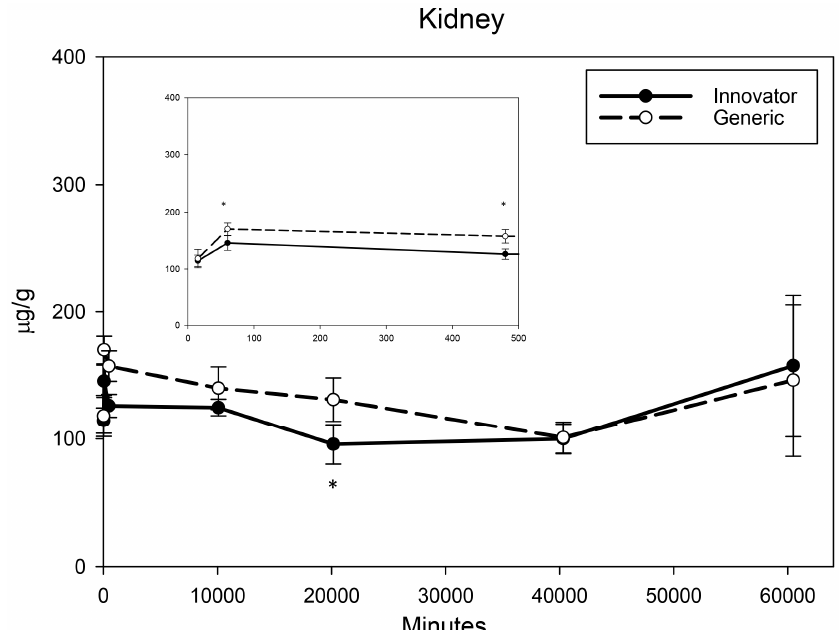
Figure 6. Kidney mean iron concentrations over time. Endogenous (control) iron concentration was subtracted from both the innovator (solid) and the generic (dashed). Negative results are not graphed. Time points = 15 min, 60 min (1 h), 480 min (8 h), 10,080 min (1 week), 20,160 min (2 weeks), 40,320 min (4 weeks), 60,480 min (6 weeks). Inset shows the first three time points (15 min, 1 h, 8 h). Values are shown as mean + SD; n = 6 per group per time point; * p < 0.05.